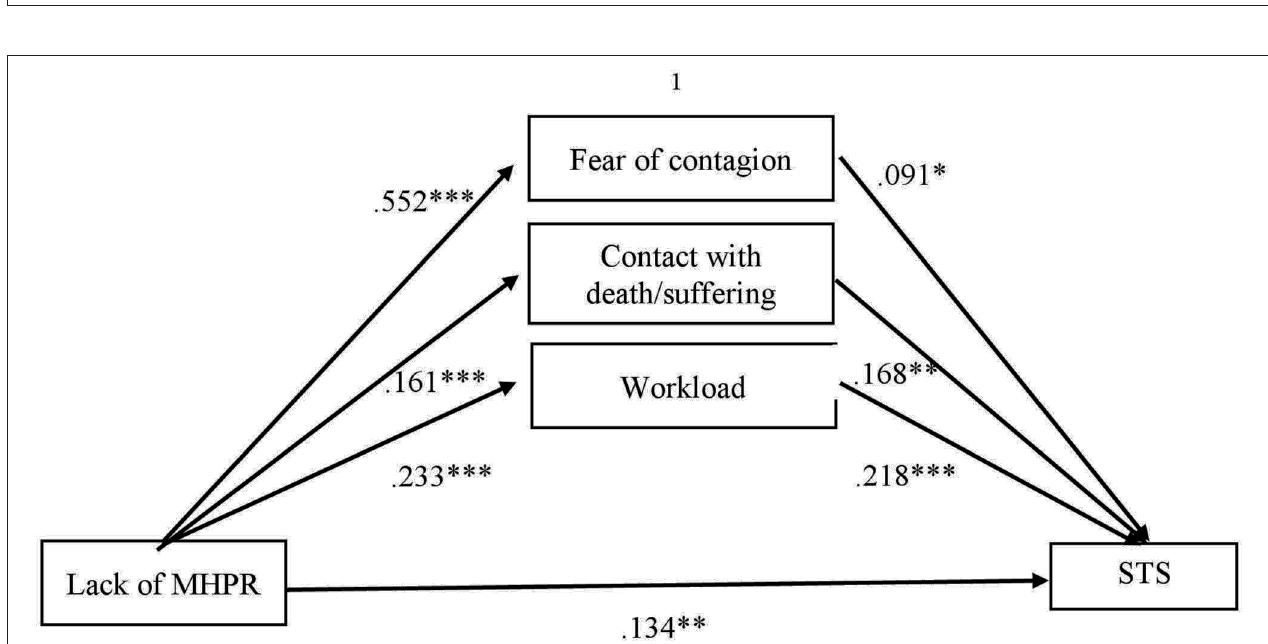
FIGURE 2 | Mediational effects of job demands on lack of MHPR in predicting Emotional Exhaustion (EE). MHPR, Material and Human Protection Resources; EE, Emotional Exhaustion. 1 Total indirect effect of lack of MHPR on EE through workload ( β = 0.12; t = 2.97; p > 0.01). ** p < 0.01.